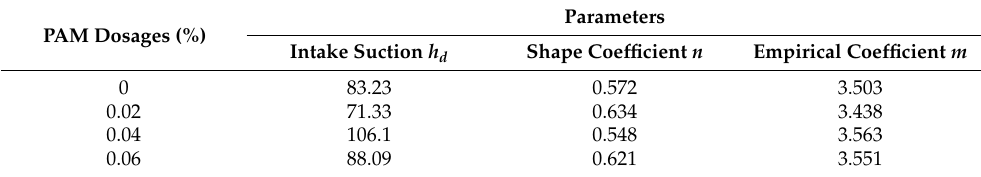
Table 4. Parameters of the Brooks-Corey model relative to the PAM amendment